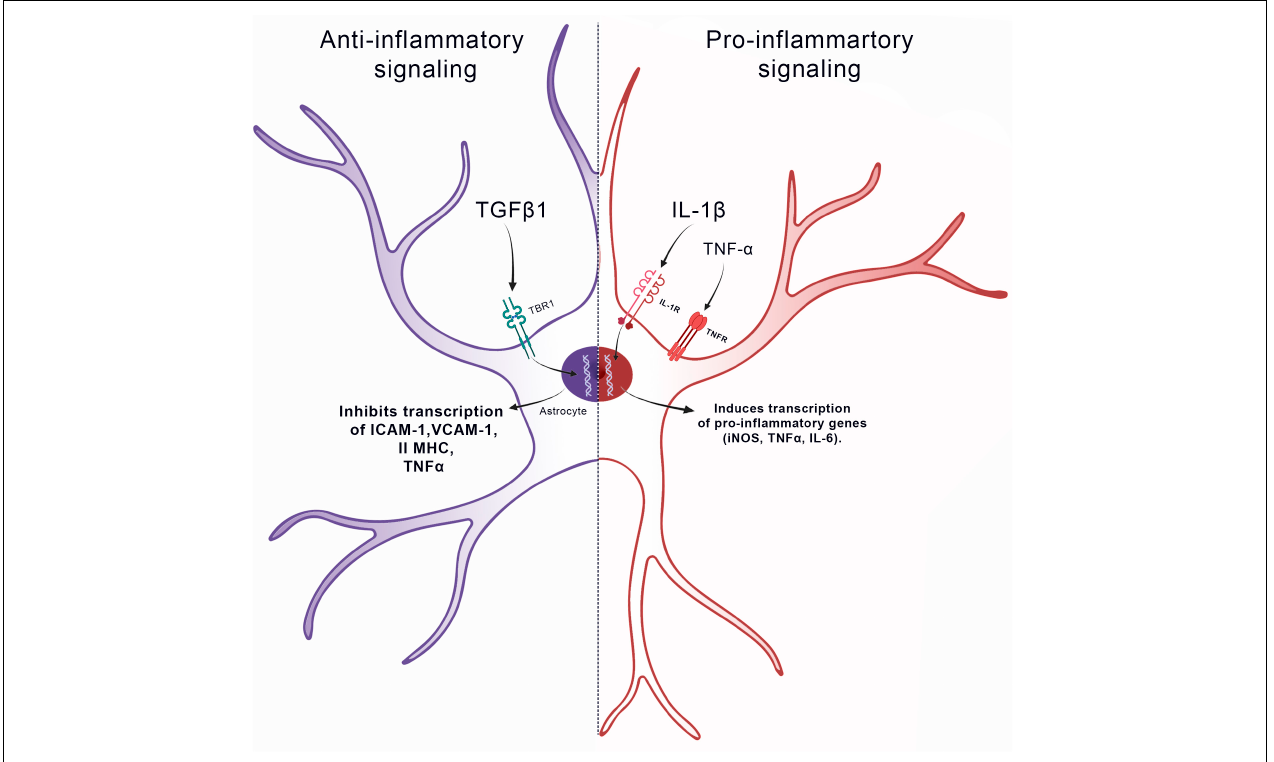
FIGURE 1 | Role of cytokines in promoting astrocytosis. IL1 β , IL-6, TNF, and IFN γ induce a pro-inflammatory signaling pathway in the astrocyte, stimulating the gene transcription of iNOS, IL-6, and TNF- α . On other hand, TGF- β 1 induces an anti-inflammatory signaling pathway in the astrocyte, inhibiting the gene transcription of ICAM-1, Vcam-1, II MHC, and TNF- α